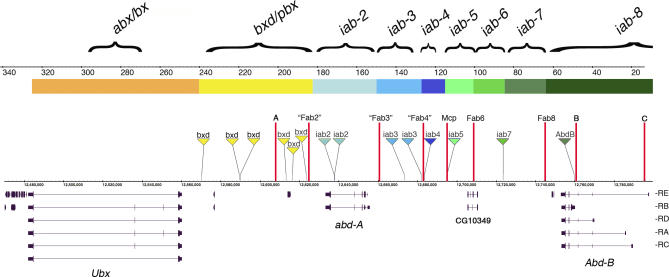
CTCF Binding Sites Demarcate Boundaries in the BX-CThe top track shows the BX-C cis-regulatory regions above a coordinate line with numbering according to Martin et al. [20]. The coloured bar indicates the regulatory domains according to Maeda and Karch [28]. The orange/yellow regions (abx/bx and bxd/pbx) control Ubx expression. The blue shaded regions (iab-2, 3, and 4) control abd-A expression, and the green regions (iab-5 to 9) regulate Abd-B. Above the Drosophila genome Release 4 coordinate line, are shown the insertion points and associated regulation of a set of enhancer-trap insertions [27]. The locations of CTCF sites are indicated by red vertical bars. The positions of the CTCF sites correlate well with the boundaries of the cis-regulatory regions and separate sets of enhancer-traps with different regulation.